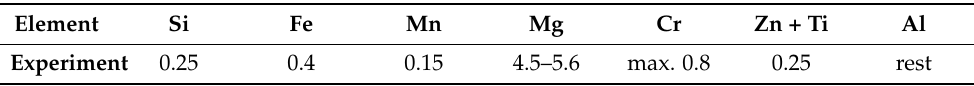
Table 5. Chemical composition of the filler material according to the material testimonial.